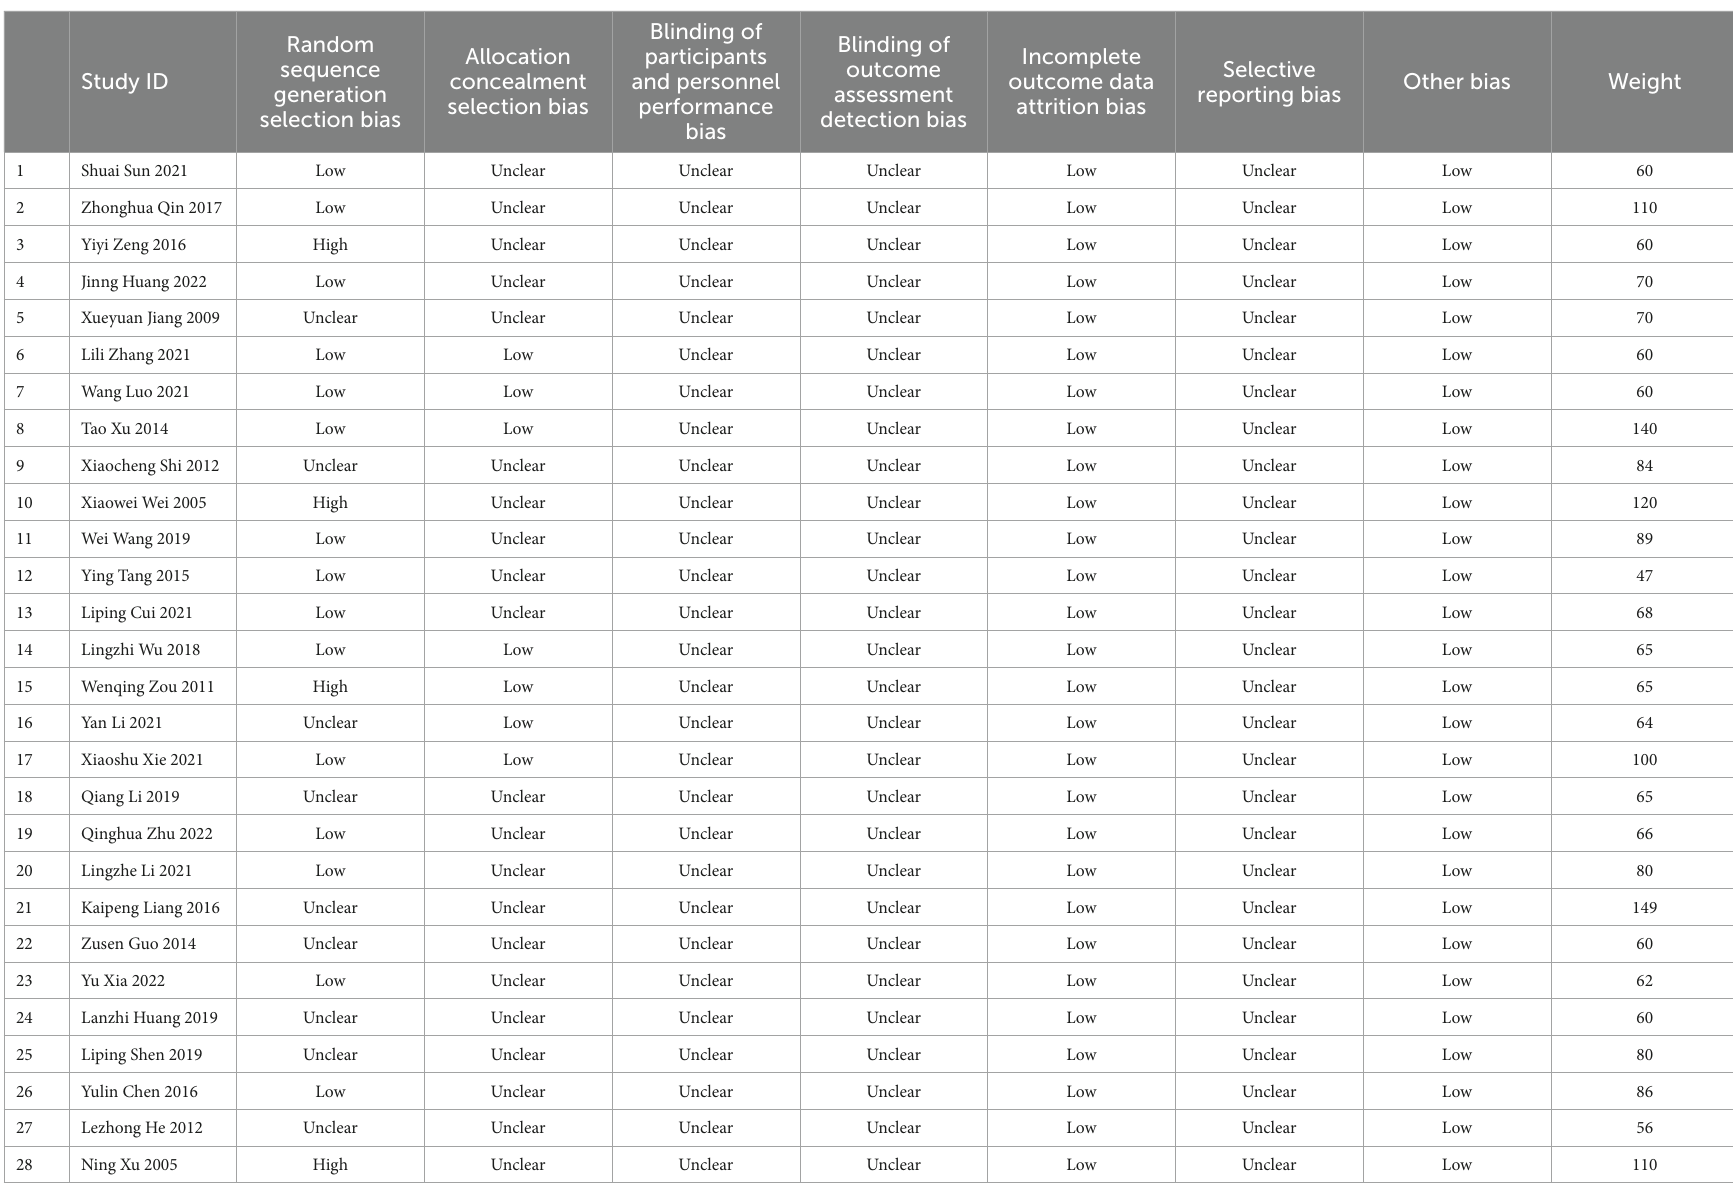
TABLE 2 Result of data extraction and